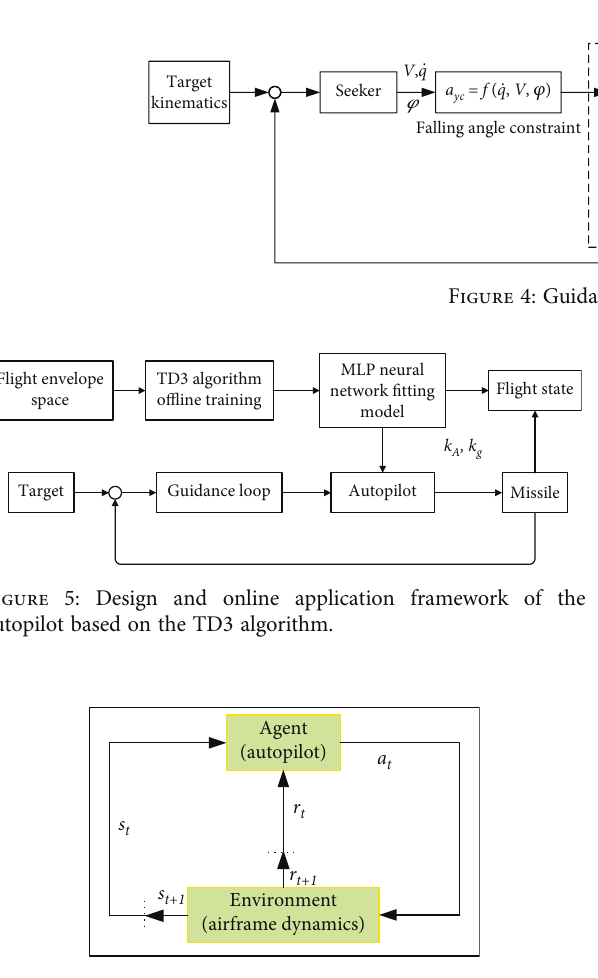
Figure 6: The interaction process between the agent and the environment in the